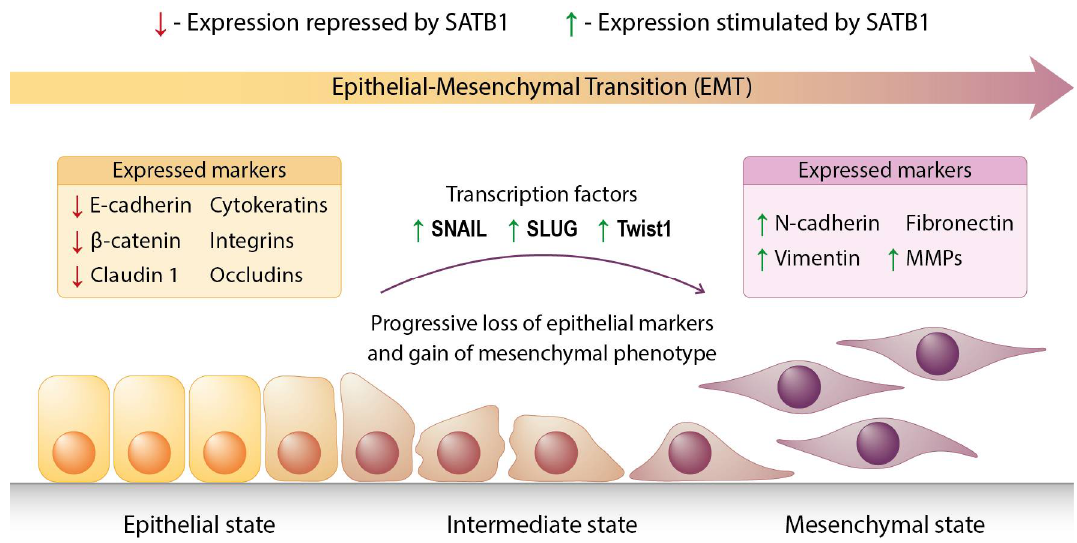
Figure 1. Diagram depicting the epithelial-mesenchymal transition process. Cobblestone-like epithelial cells (“Epithelial state”, on the left) gradually lose their junctions and apical-basal polarity, and become spindle-shaped and invasive (“Mesenchymal state”, on the right). The epithelial and mesenchymal markers commonly used to describe EMT progression are listed above the specific cells. The transition process is mediated by the three main transcription factors: SNAIL, SLUG, and Twist1. The impact of SATB1 on the expression of particular factors is indicated by the red (expression repressed) or green (expression stimulated) arrows.